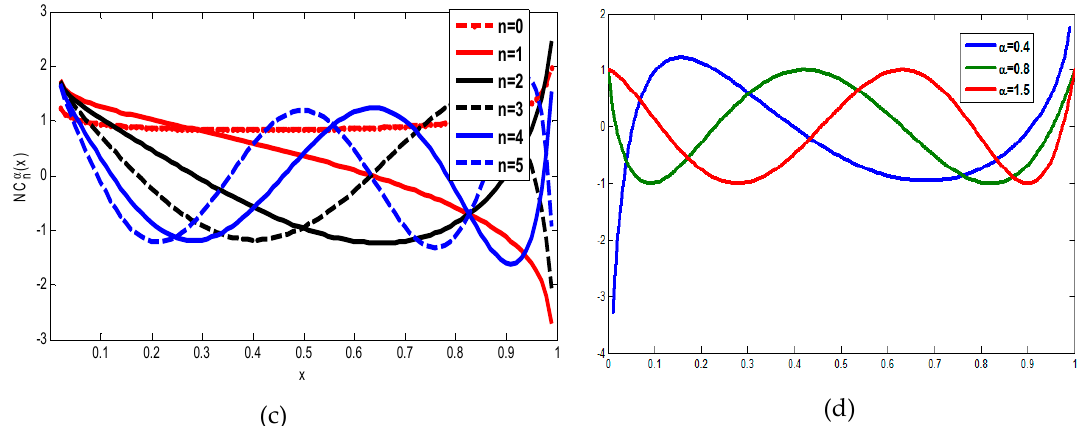
Figure 1. ( a ) Shows fractional order Chebyshev polynomials with di ff erent values of n , α = 0.8. ( b ) Shows fractional order Chebyshev polynomials with n = 4 and di ff erent values of α = 0.4, 0.8, 1.2, 1.6. ( c ) Normalized Chebyshev polynomials with di ff erent orders n = 0, 1, 2, 3, 4, 5. ( d ) Normalized Chebyshev polynomials with n = 4, α = 0.4, 0.8,1.5.